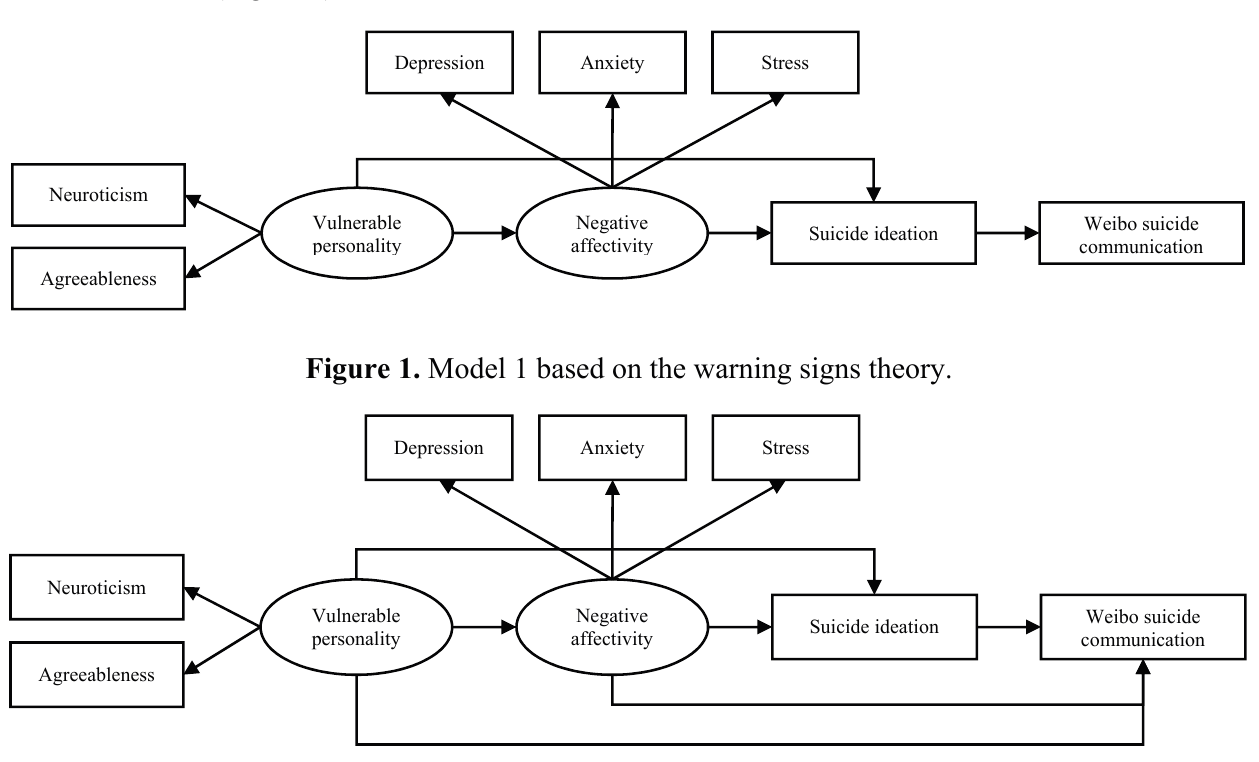
Figure 2. Model 2 based on the warning signs theory and the cry for help